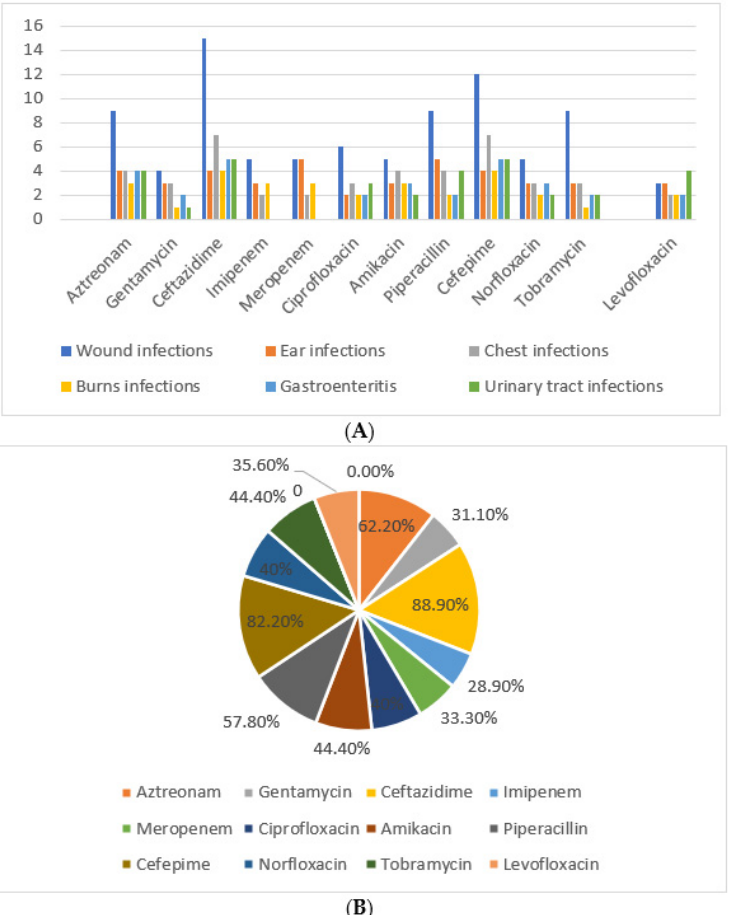
Figure 1. ( A ): Resistance pattern of P. aeruginosa isolates among the different infections. ( B ): Percent of antibiotic resistance correlated to 45 P. aeruginosa isolates.